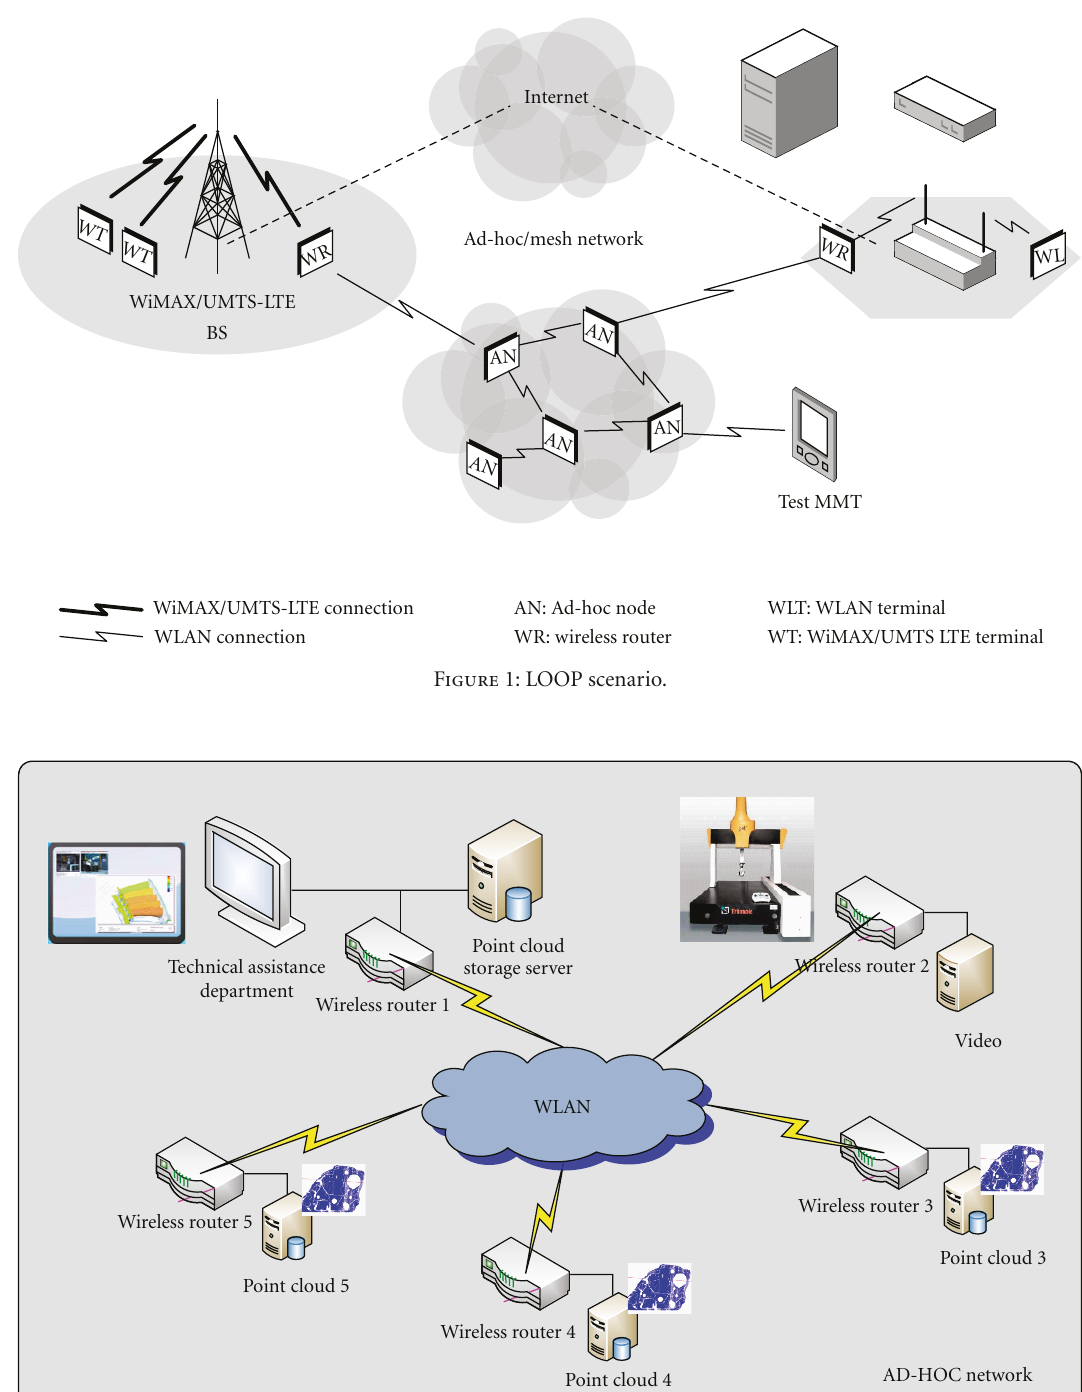
Figure 2: TRIMEK